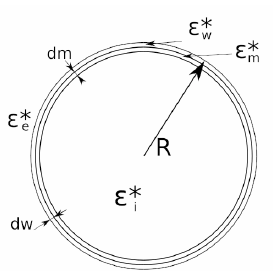
Figure 5. Yeast cell model with three compartments. ε w* : complex permittivity of the cell wall. ε m* : complex permittivity of the cell membrane. ε e* : extracellular medium permittivity. ε i* : intracellular medium permittivity. dm: cell membrane width. dw: cell wall width. R: cell radius.